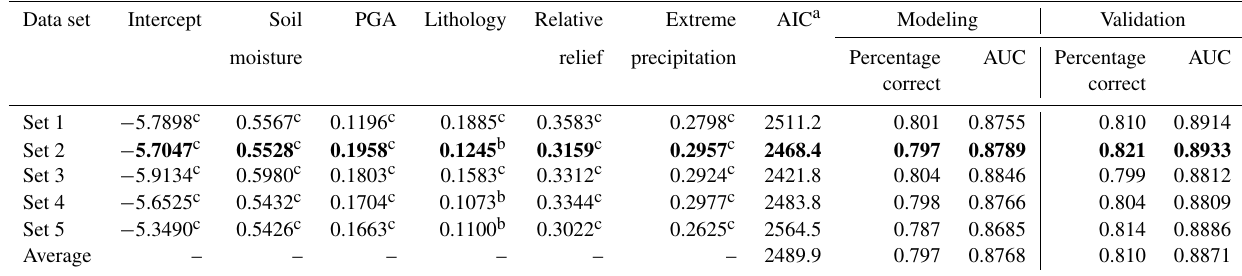
Table 4. Model results of stepwise logistic regression for each data set. The best fit model is in bold font. Data